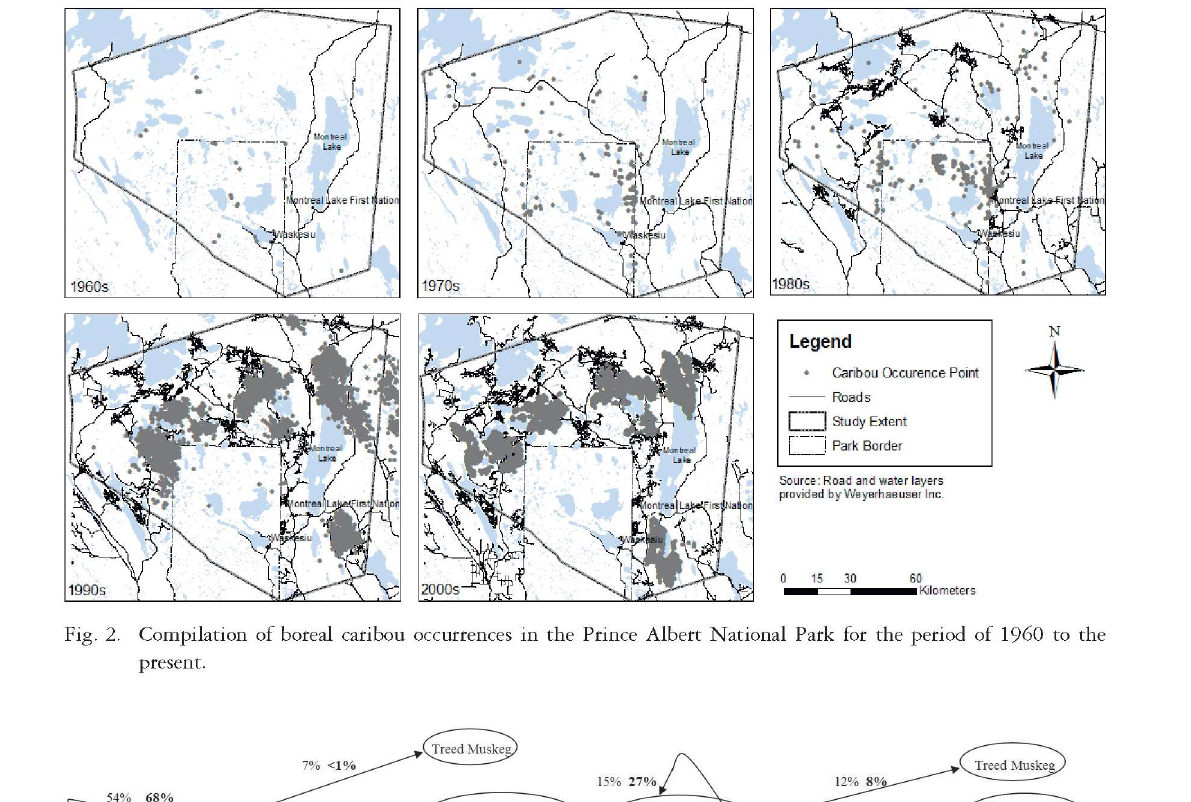
Fig. 2. Compilation of boreal caribou occurrences in the Prince Albert National Park for the period of 1960 to the present.